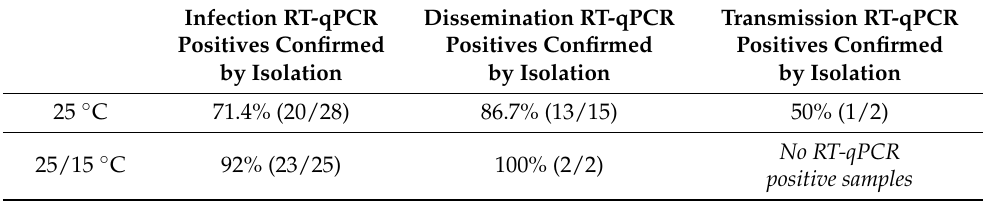
Table 2. Virus isolation of RT-qPCR-positive samples for infection, dissemination and transmission. All ratios are given in percentages with the respective absolute numbers between